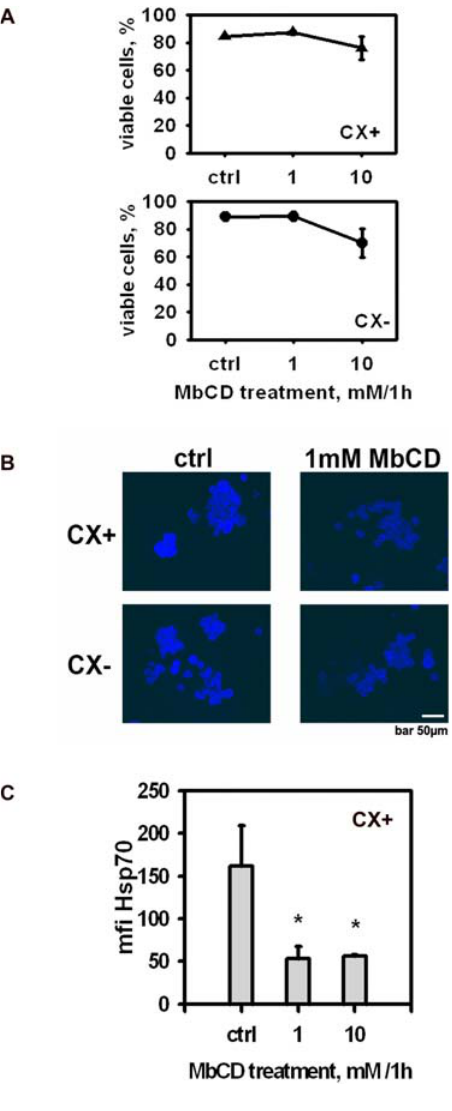
Figure 2. Hsp70 is associated with detergent resistant micro- domains (DRMs). (A) Definition of the sublethal concentration of the raft disrupting agent methyl-beta cyclodextrin (MbCD). Following incubation of CX + and CX 2 tumor sublines with 1 and 10 mM MbCD for 1 h, cells were washed and viability was determined by trypan blue staining after a 12 h recovery period. (B) The images show filipin III binding to untreated (ctrl, left graphs) and to CX + /CX 2 tumor sublines treated with the sublethal concentration of 1 mM MbCD (right graphs) for 1 h. (C) Cell surface density of Hsp70 in untreated (ctrl) and MbCD (1 mM, 10 mM) treated CX + cells. Viability was 97.7 6 0.4 for control and 95 6 0.7 for MbCD treated cells. The data represent mean fluorescence intensity (mfi) values of three independent flow cytometric analyses. *Indicates values that are significantly different from control (P=0.006).